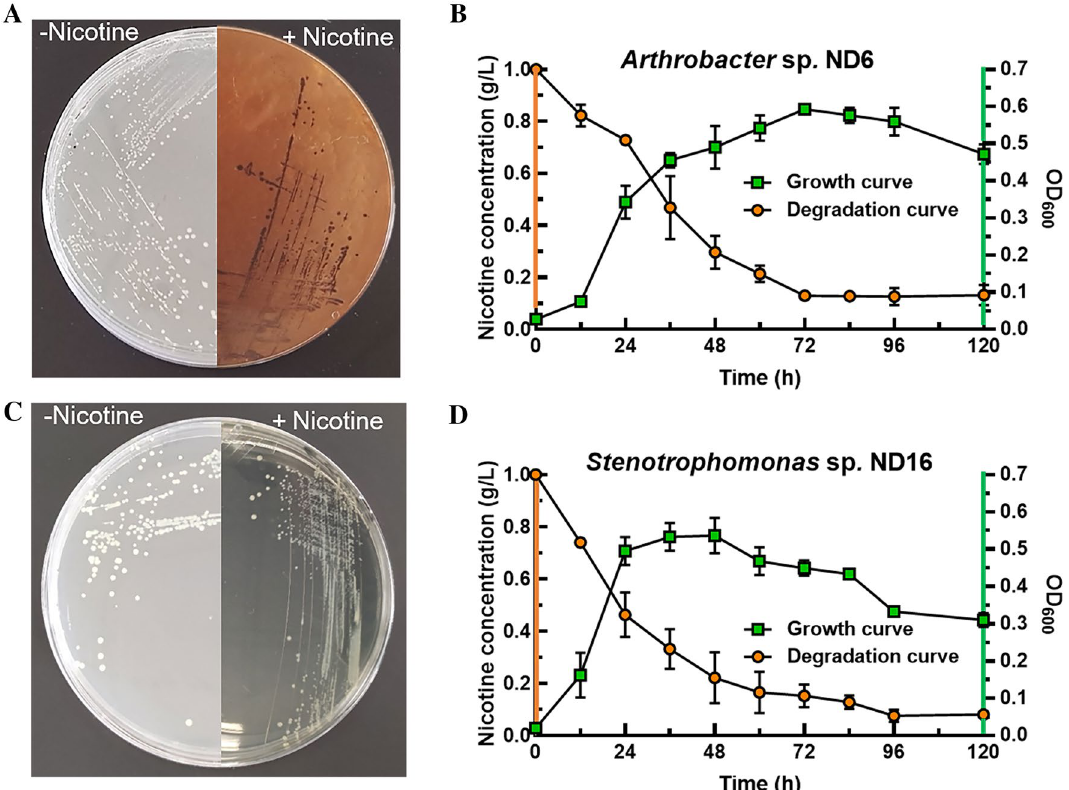
Fig. 3 Strains ND6 and ND16 growing on plate and liquid medium with 1.0 g/L of nicotine as sole carbon source. A , C The strains grew on the plate; B , D growth curves and nicotine-degrading curves under 28